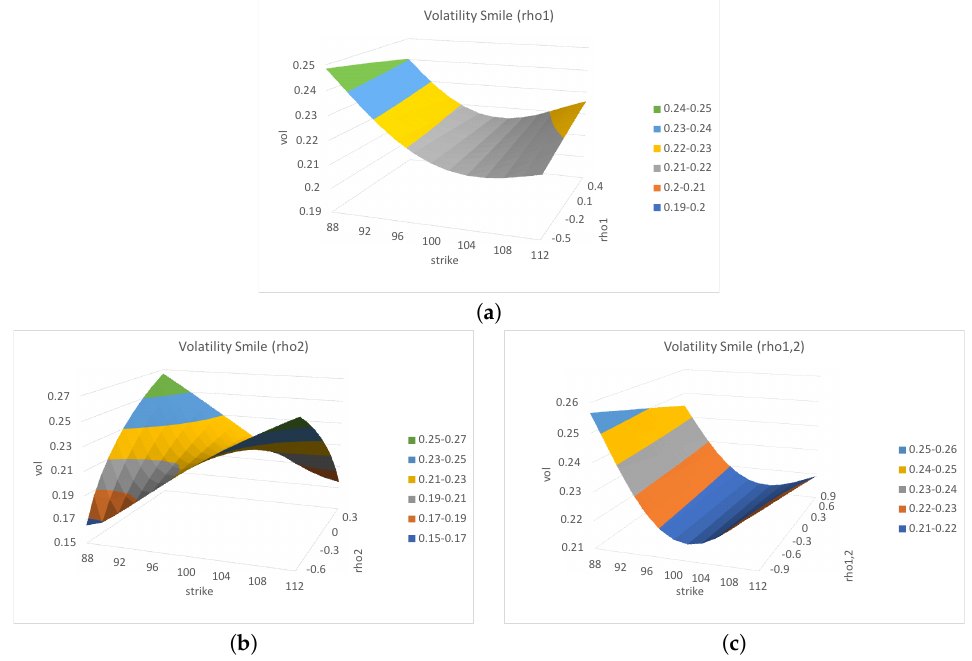
Figure 6. Volatility smile with respect to the correlations. ( a – c ) show the volatility smile of ρ 1 , ρ 2 , and ρ 3 , respectively. The maturity is T = 0.16 and the other parameters are listed in Table 1.